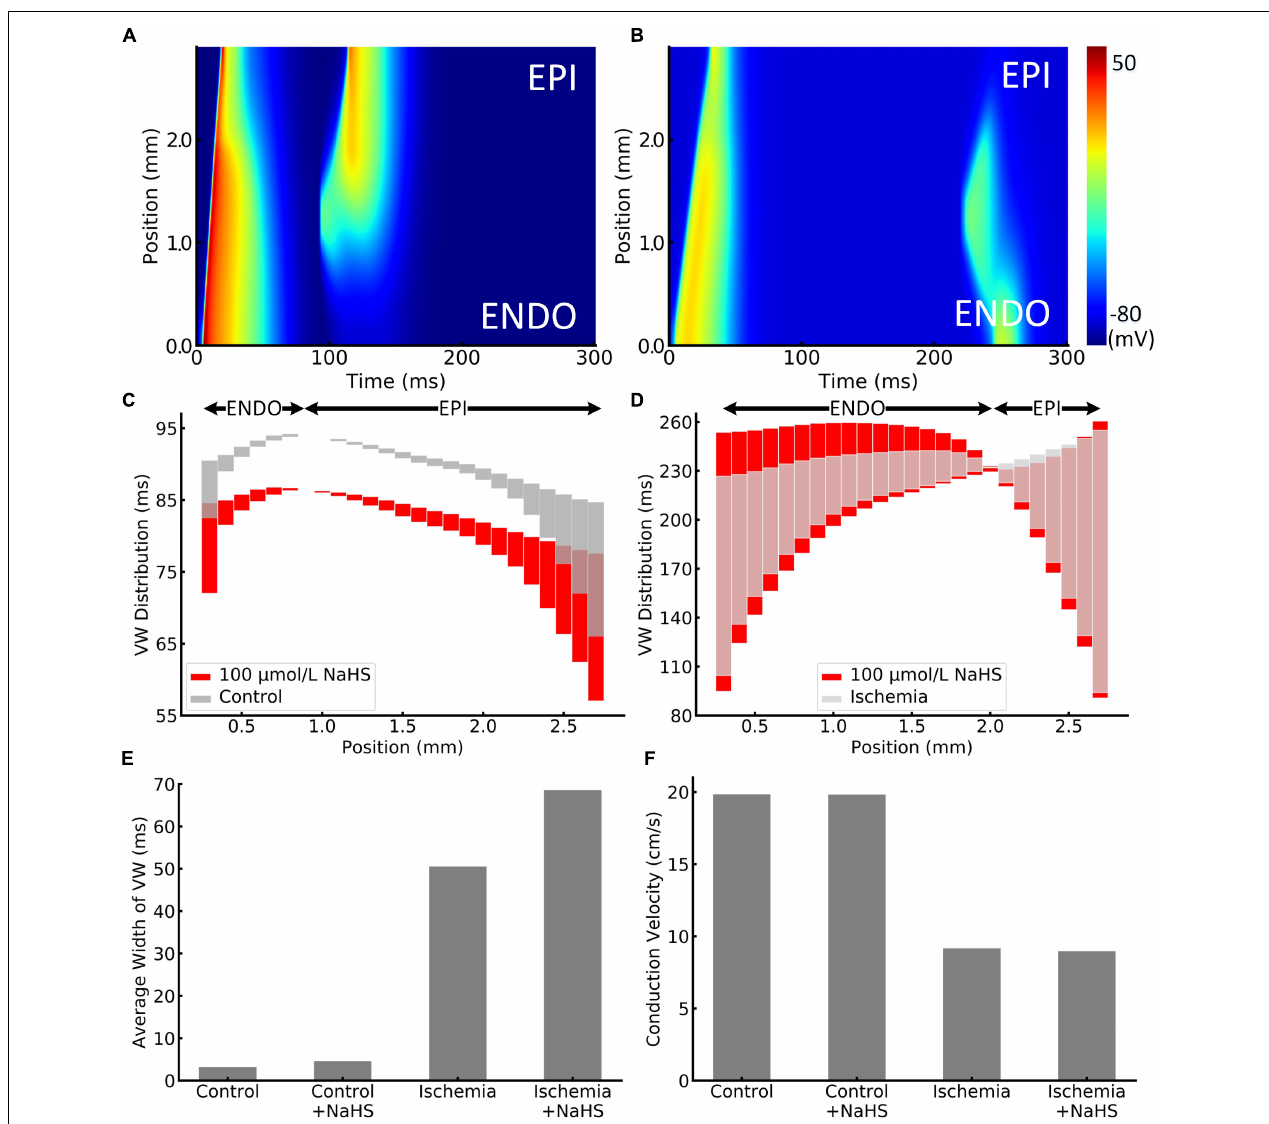
FIGURE 4 | Illustration of unidirectional conduction block in (A) healthy and (B) ischemic 1D tissue strand. The vulnerable window (VW) distribution of different positions in strand is plotted in (C) healthy and (D) ischemic tissues. VWs were widened by NaHS in both healthy and ischemic tissues, presented as red bars. Arrows at the top represent the epicardial or endocardial direction toward which the impulse could be conducted. VWs that are less than 0.01 ms were ignored, as they might be incorrectly calculated because of the time precision in the model. The average width of VW in all cases is compared in panel (E) . In addition, the measured conduction velocity in 1D strand is shown in panel (F)